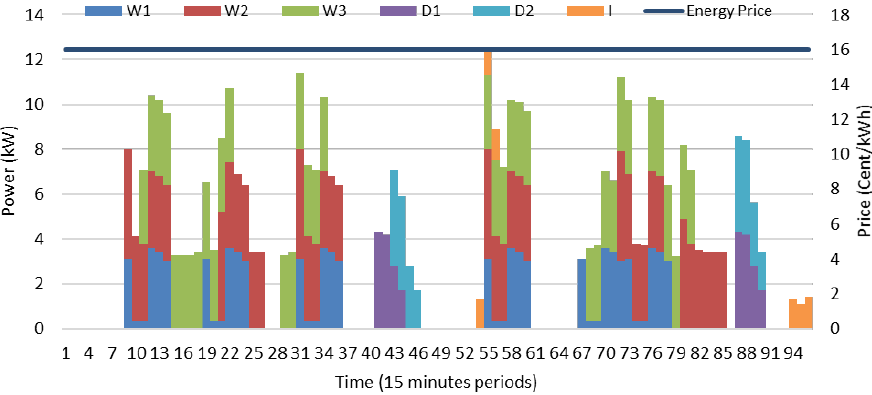
Figure 4. Power consumption of devices in scenario A (based on single-tariff pricing).